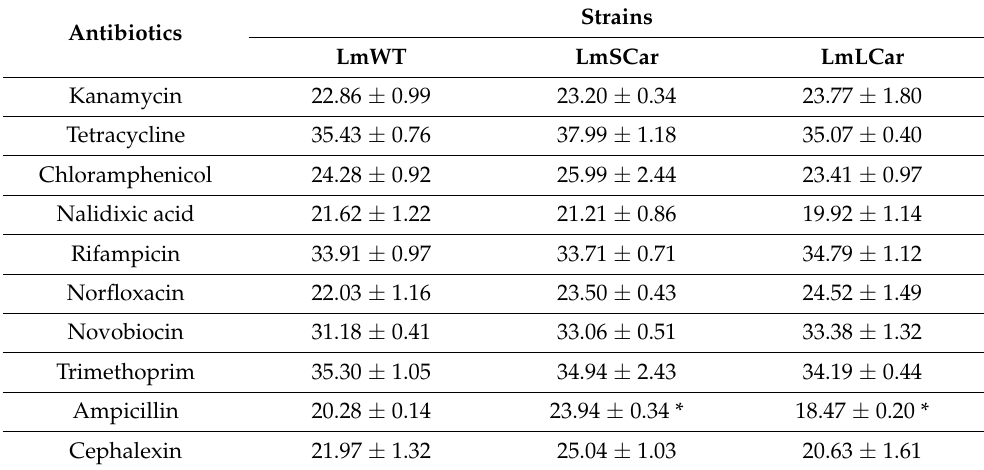
Table 2. Diameters (mm) of growth inhibition halos observed in agar disk diffusion assays of Listeria monocytogenes EGD-e (LmWT) and its evolved strains, LmSCar (exposed to prolonged sublethal doses of carvacrol) and LmLCar (cyclically exposed to short lethal treatments of carvacrol), against antibiotics: 30 µ g of kanamycin sulfate, 30 µ g of tetracycline, 30 µ g of chloramphenicol, 400 µ g of nalidixic acid sodium, 5 µ g of rifampicin, 30 µ g of norfloxacin, 150 µ g of novobiocin sodium, 10 µ g of trimethoprim, 10 µ g of ampicillin, and 150 µ g of cephalexin. Each value represents the mean diameter of the inhibition halo ± standard deviation from three independent experiments. Strains Antibiotics LmWT LmSCar LmLCar Kanamycin 22.86 ± 0.99 23.20 ± 0.34 23.77 ± 1.80 Tetracycline 35.43 ± 0.76 Chloramphenicol